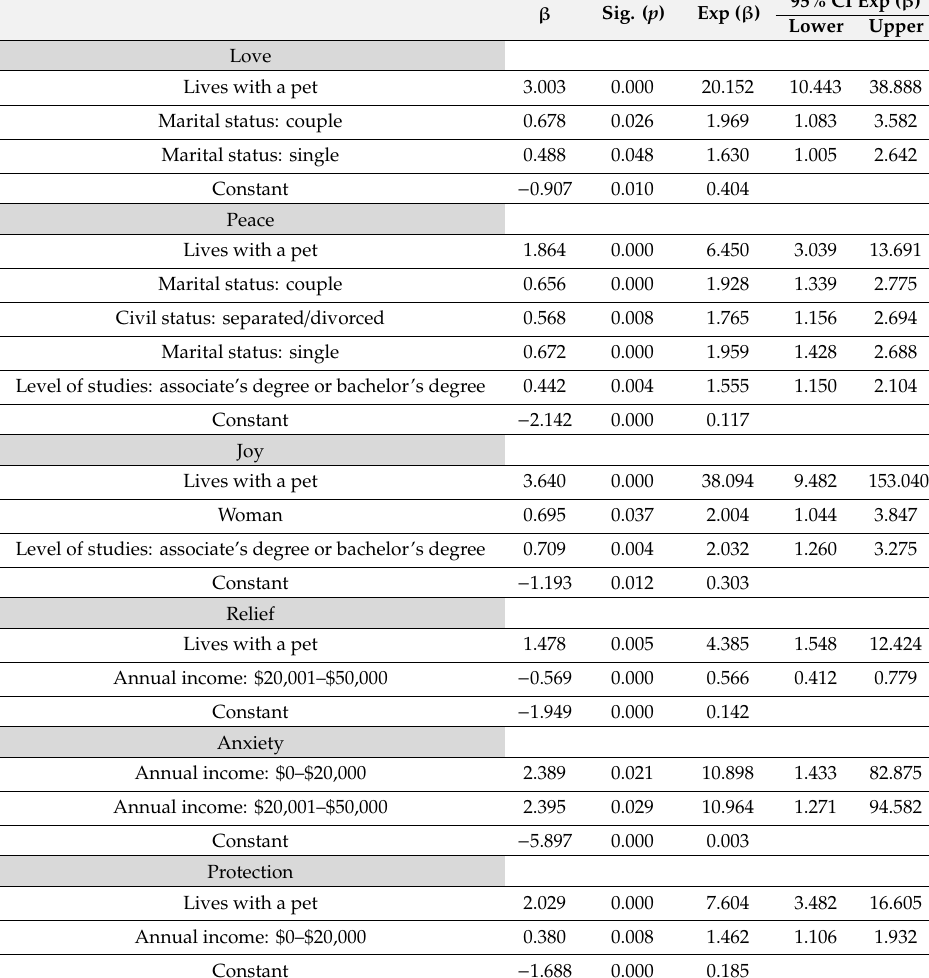
Table 5. Summary of the predictive variables of the binary logistic regressions carried out for the significant analyzed